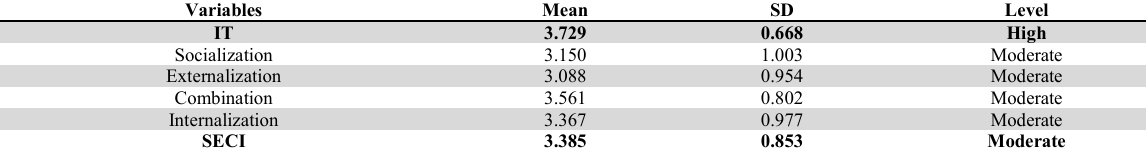
The arithmetic mean and the standard deviation of the fields of